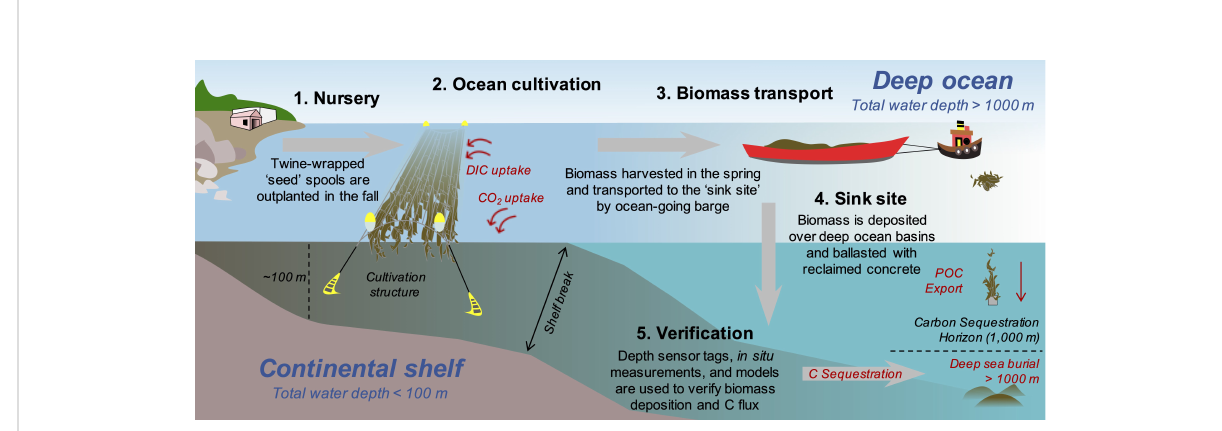
FIGURE 1 Conceptual diagram of offshore macroalgae cultivation in the Gulf of Maine and intentional deep-ocean sinking as a method of carbon dioxide removal (CDR). Juvenile sporophytes are grown within a land based nursery during the summer and then outplanted on twine-wrapped PVC “ spools ” in the fall. The cultivation site is located ~20km from the Maine coastline. As kelp uptake dissolved inorganic carbon (DIC) to build tissue, the DIC de fi cient seawater equilibrates with the atmosphere and draws down atmospheric CO 2 into the oceanic C pool. In the spring, kelp biomass is harvested and then transported ~350 km using ocean-going barges to the deep-ocean “ sink site ” located at the edge of the continental shelf. Biomass is ballasted using reclaimed concrete and deposited below the Carbon Sequestration Horizon (1,000 m). Lastly, a combination of in situ measurements and modeling is used to verify the quantity of CO 2 eq